Question: What style of plot is this figure drawn as?
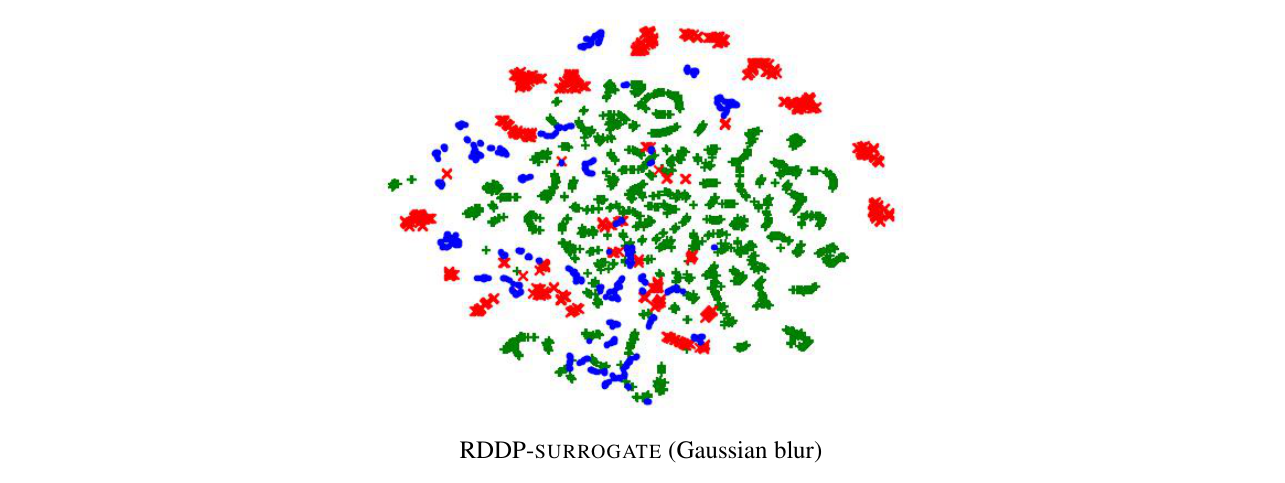
Answer: scatter